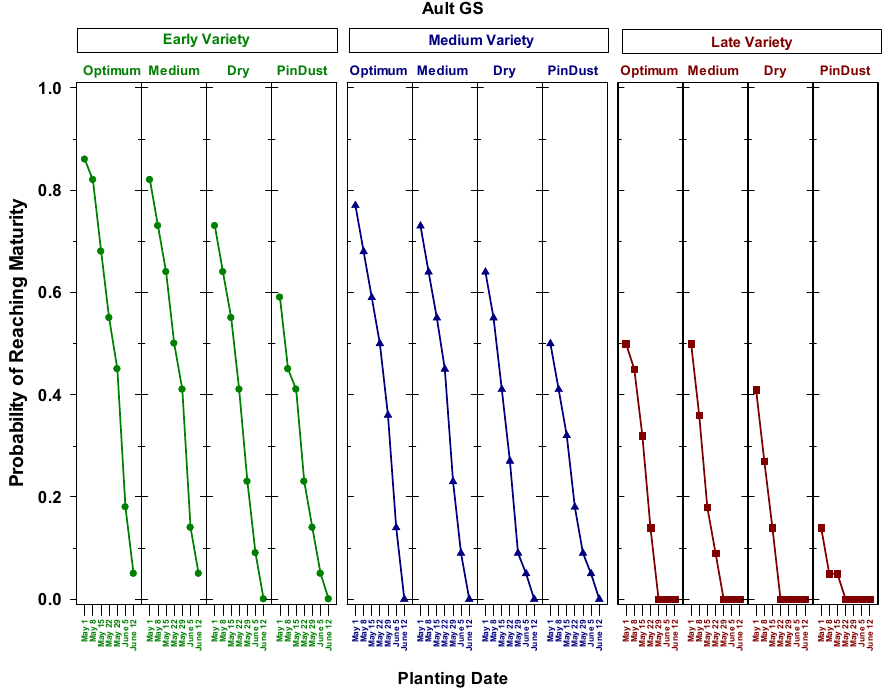
Figure 6. Probability of sorghum reaching physiological maturity at Ault, Colorado, for seven planting dates using non ‐ stressed (GS) phenological parameters, three maturity classes, and four seedbed water conditions at planting.